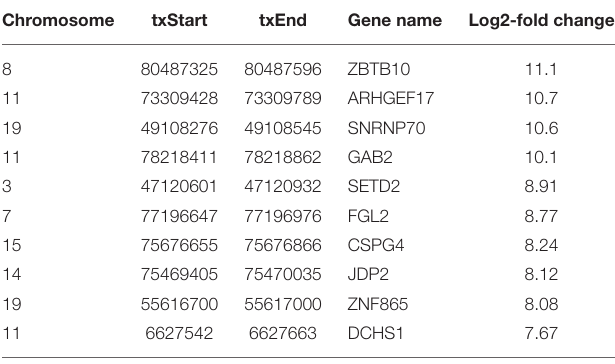
TABLE 3 | Top 10 up methylated m6A peaks.